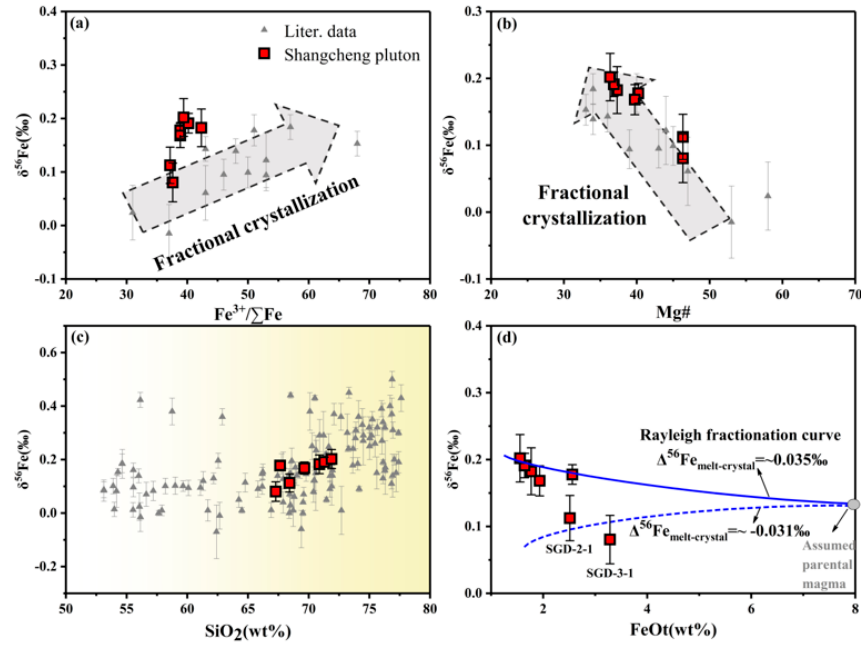
Figure 10. ( a ) Fe 3+ / ∑ Fe vs. δ 56 Fe, ( b ) Mg# vs. δ 56 Fe, ( c ) SiO 2 vs. δ 56 Fe, ( d ) FeOt vs. δ 56 Fe. The data were taken from [7,12,14,65]. The blue line stands for the modelled fractionation trend of samples.